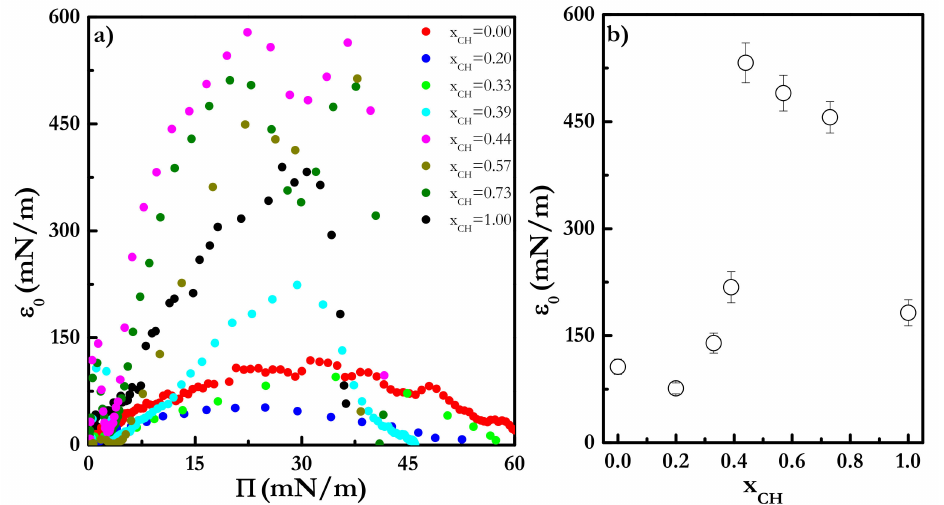
Figure 5. ( a ) Quasi-static dilational elasticity, ε 0 , dependences on the surface pressure, Π , for Langmuir monolayers of mixtures of CH and CE spread at the water/vapor interface at 24 ◦ C. ( b ) Dependence of the quasi-static dilational elasticity, Π = 35 mN/m at 24 ◦ ε 0 , on the CH molar fraction, x CH , at